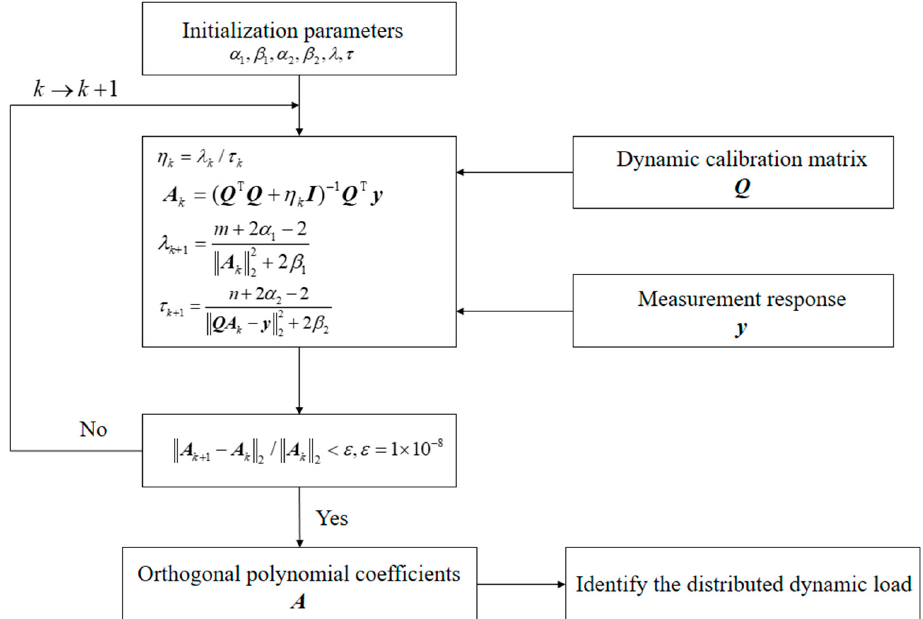
Figure 2. Schematic diagram of the distributed dynamic load identification.